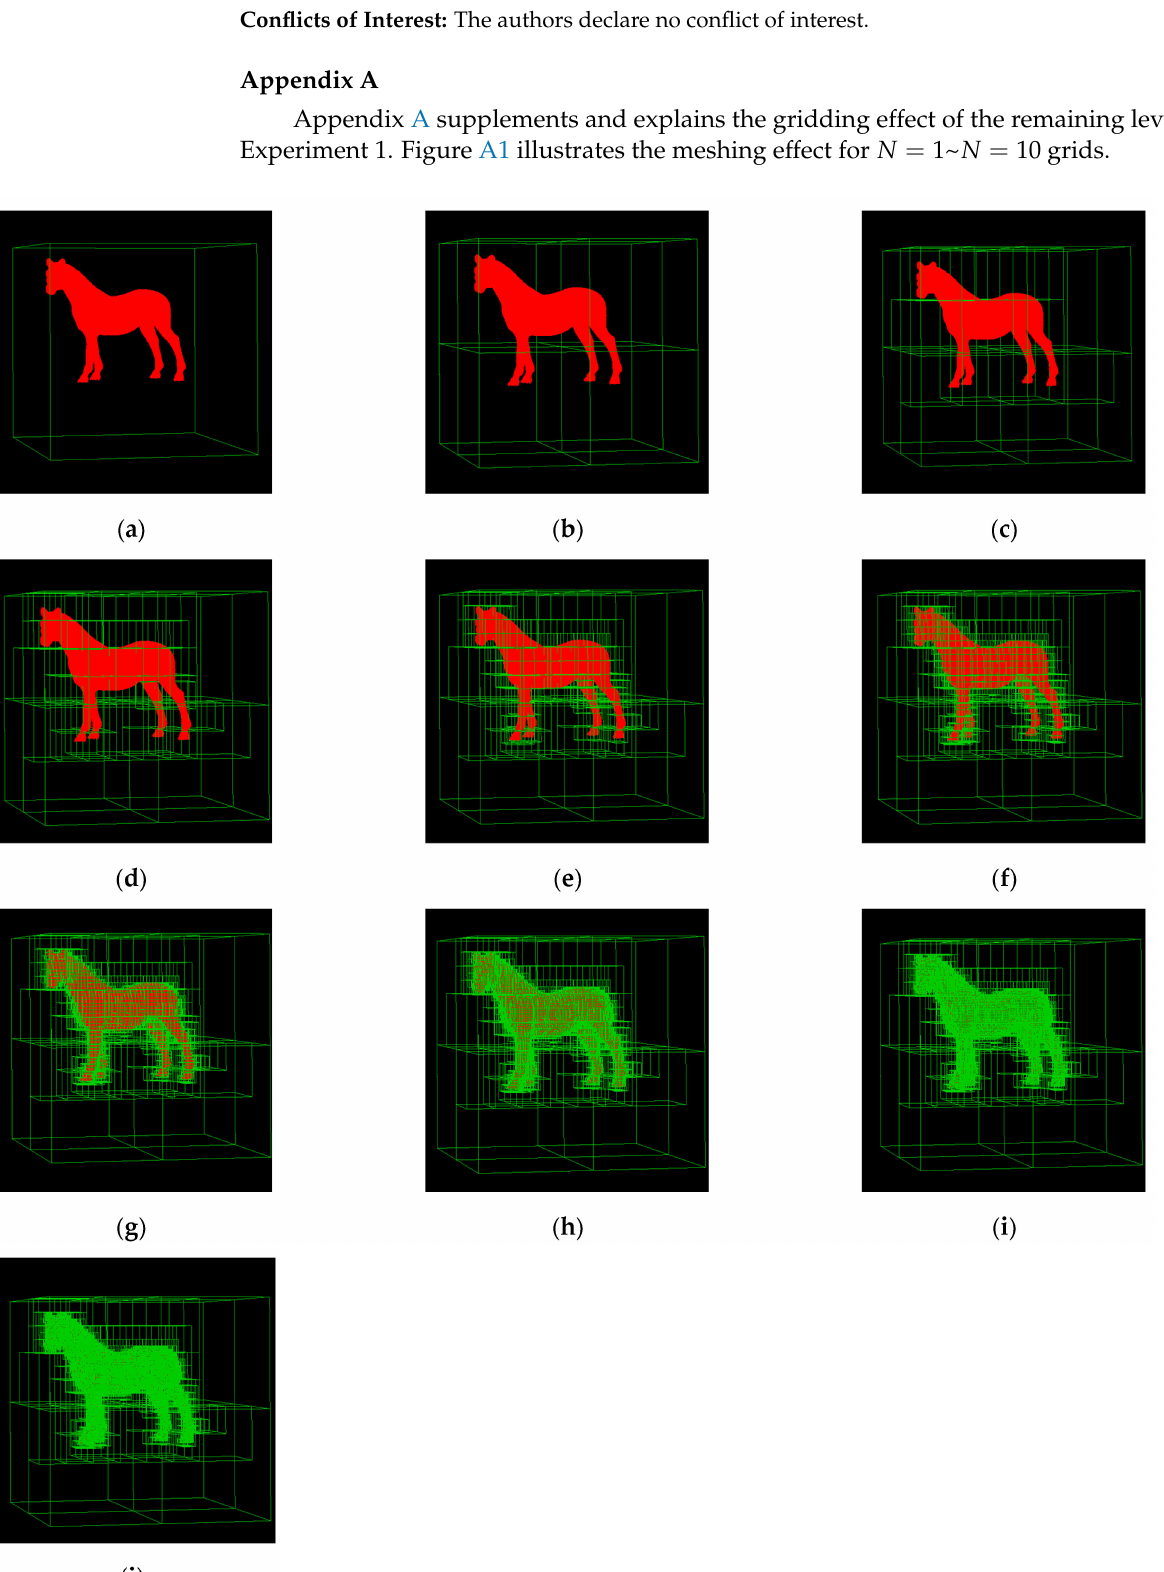
Figure A1. Single-scale Octree Grid Sectioning Hierarchical Experiment, with a grid level of ( a ) 1, ( b ) 2, ( c ) 3, ( d ) 4, ( e ) 5, ( f ) 6, ( g ) 7, ( h ) 8, ( i ) 9, and ( j )